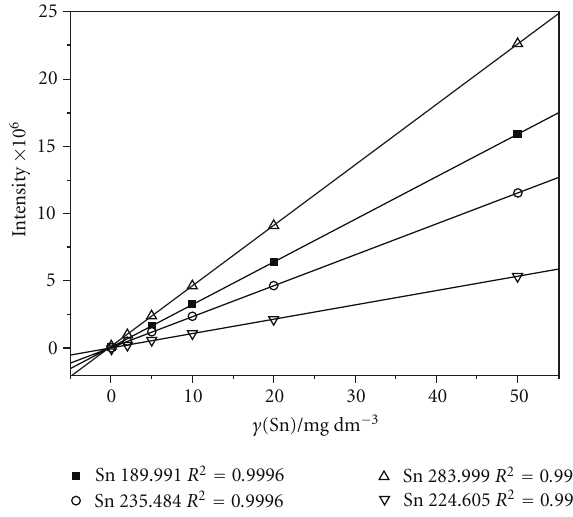
Figure 4: Calibration curves (HG-ICP-OES) in method of standard addition mode (MSA).